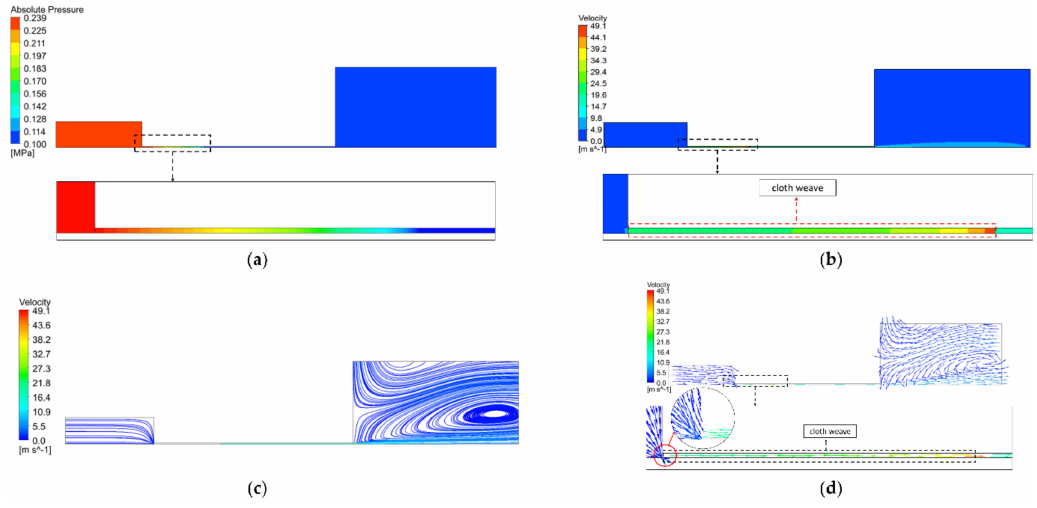
Figure 16. CFD results for diagonal direction ( C down = 0.7, ∆ P = 137.9 kPad): ( a ) pressure contours, ( b ) velocity magnitude contours, ( c ) velocity streamlines, and ( d ) velocity